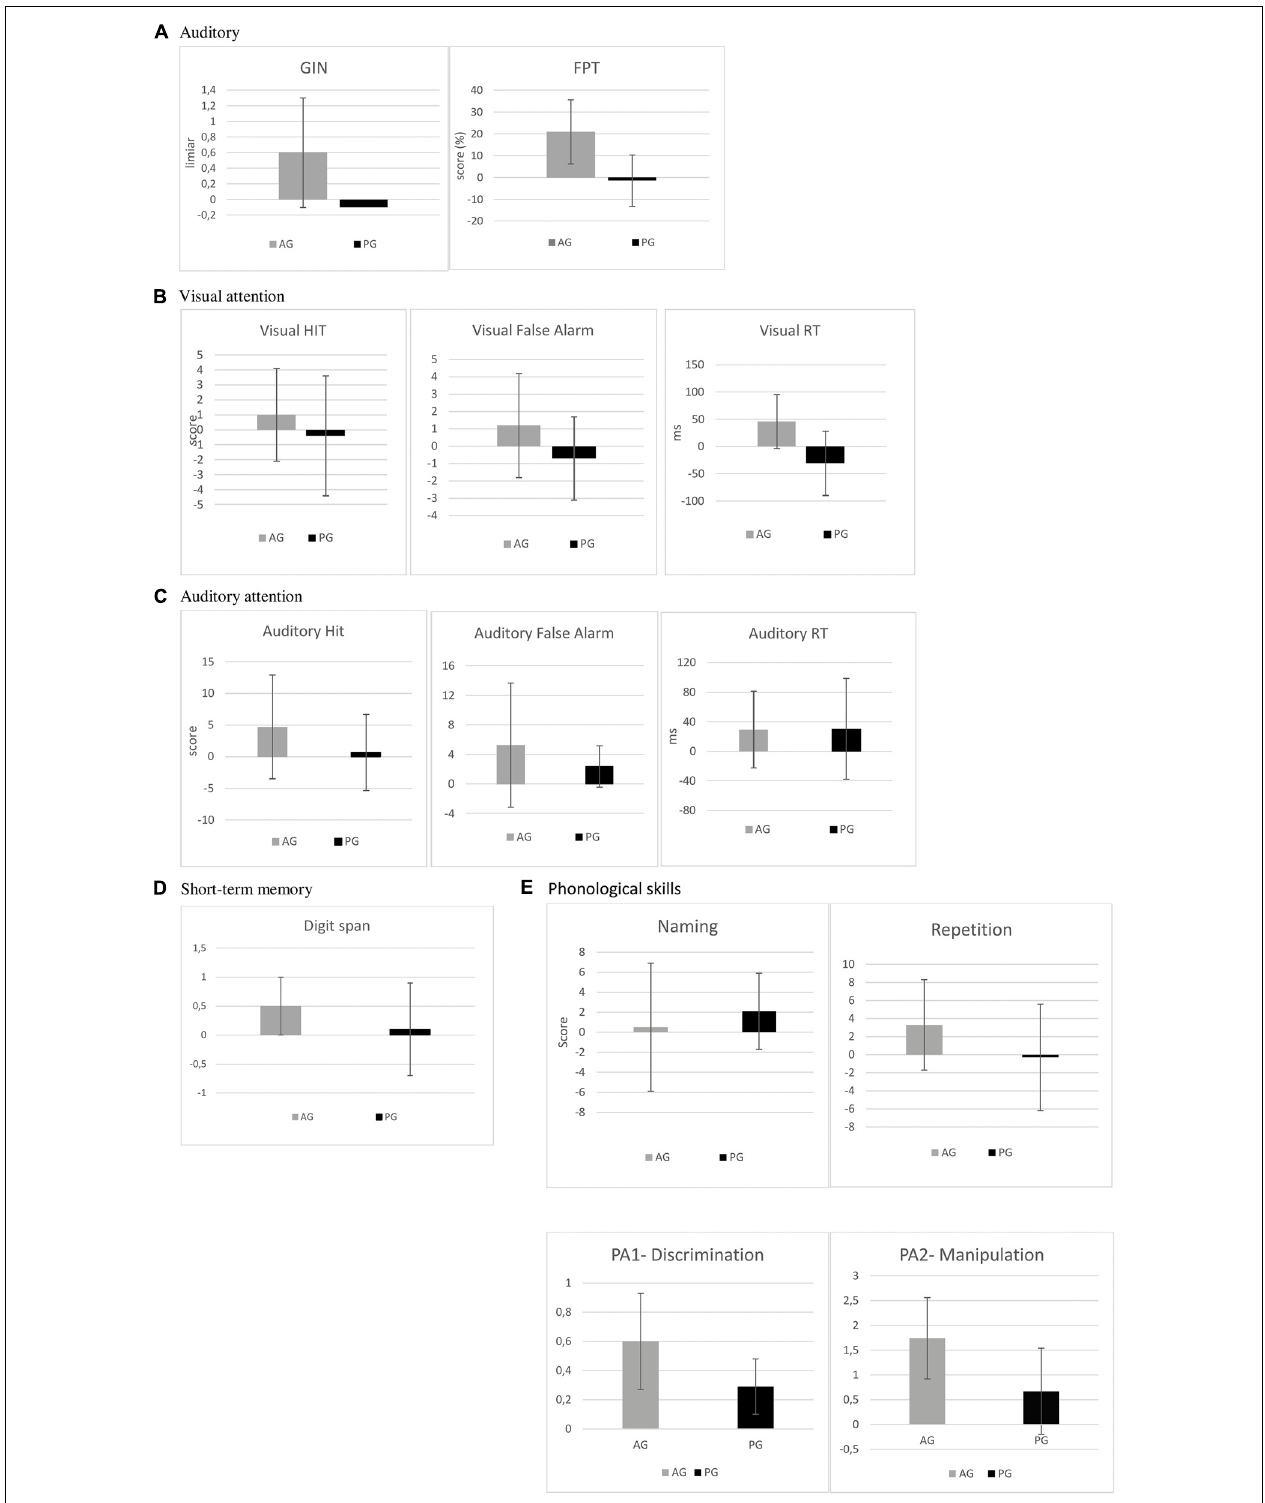
FIGURE 2 | Gains in score from pre to post-testing for theAG and PG group. (A) Percentage of increase from pre to post-testing in FPT and decrease of GIN threshold from pre to post-testing. (B,C) Increase of score in